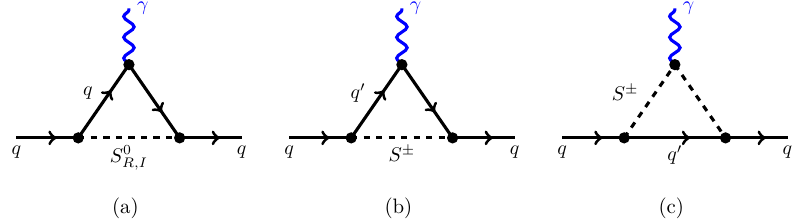
Figure 3 . Neutral S 0 and charged S ± scalars contributing to the EDM of a quark q